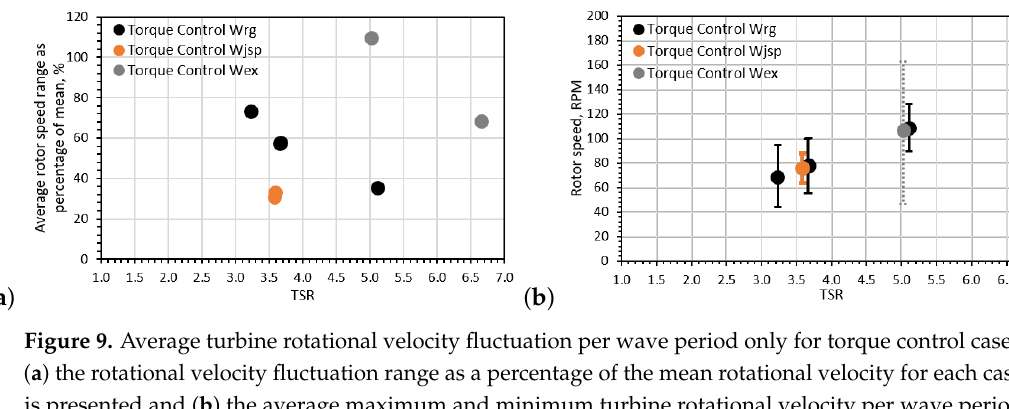
Figure 9. Average turbine rotational velocity fluctuation per wave period only for torque control cases: ( a ) the rotational velocity fluctuation range as a percentage of the mean rotational velocity for each case is presented and ( b ) the average maximum and minimum turbine rotational velocity per wave period are indicated by the extremes of the error bars.